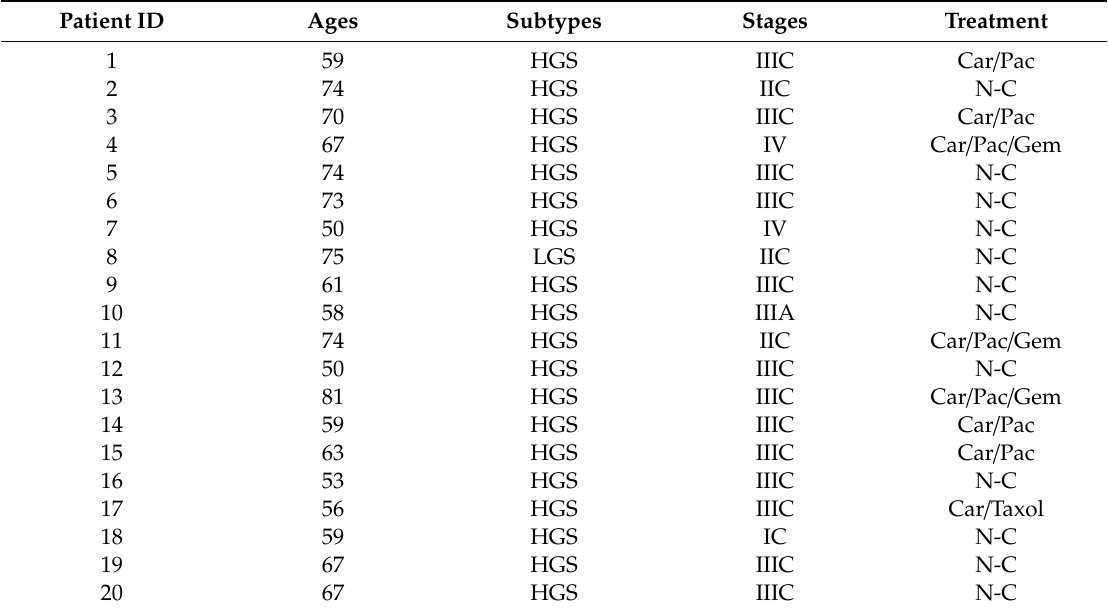
Table 1. Clinical characteristics of 20 ovarian cancer patients from a gynaecological ward, Christchurch’s Women Hospital, Christchurch, New Zealand. Of 20 patients, 19 were high grade serous (HGS) subtypes and one was a low grade serous (LGS) subtype. At the time of collecting ascitic fluids, 12 patients were newly diagnosed without having received any chemotherapy (N-C). Four patients